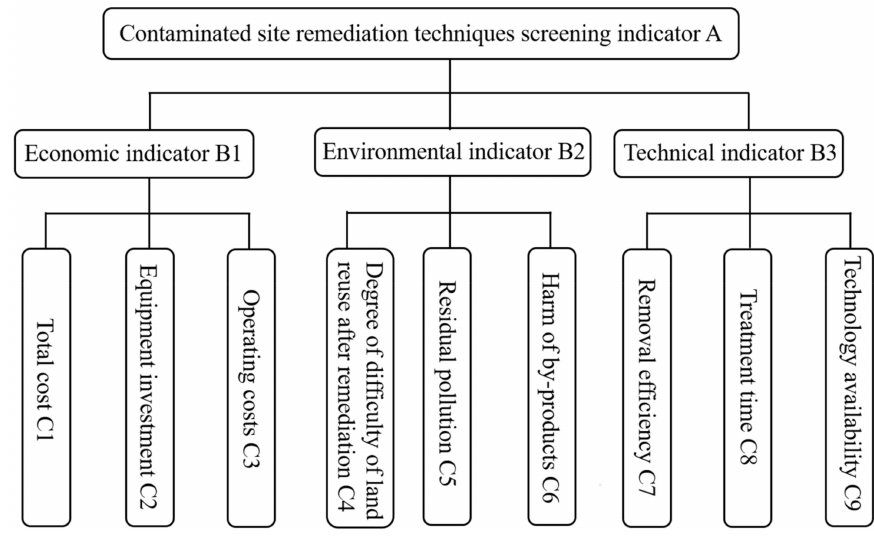
Figure 1. Hierarchical analysis model for selecting the remediation